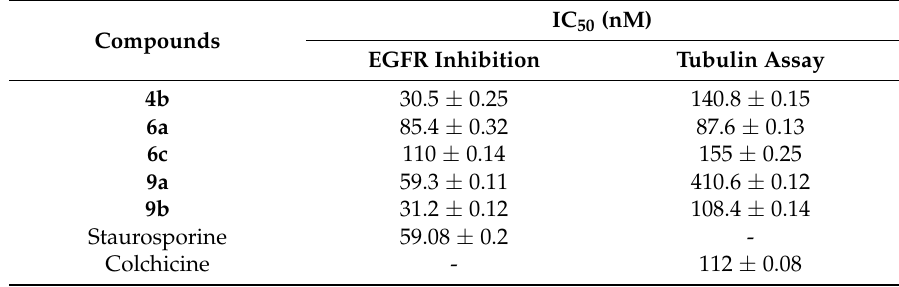
Table 2. Inhibitory data of the selected compounds to both epidermal growth factor receptor (EGFR) tyrosine kinase (TK) and tubulin